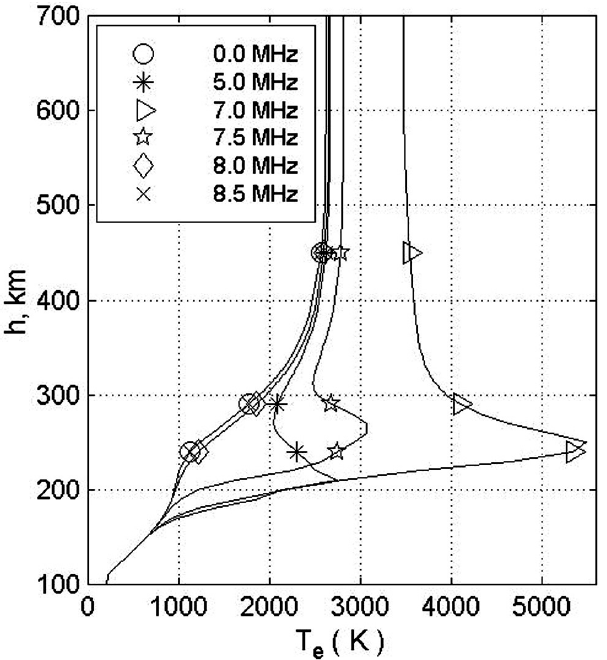
Fig. 11. Profiles of the electron concentration versus distance from the Earth along the geomagnetic field line situated in the illuminated region at S = 85 . 39km. The results are given for the same cases as in Fig.